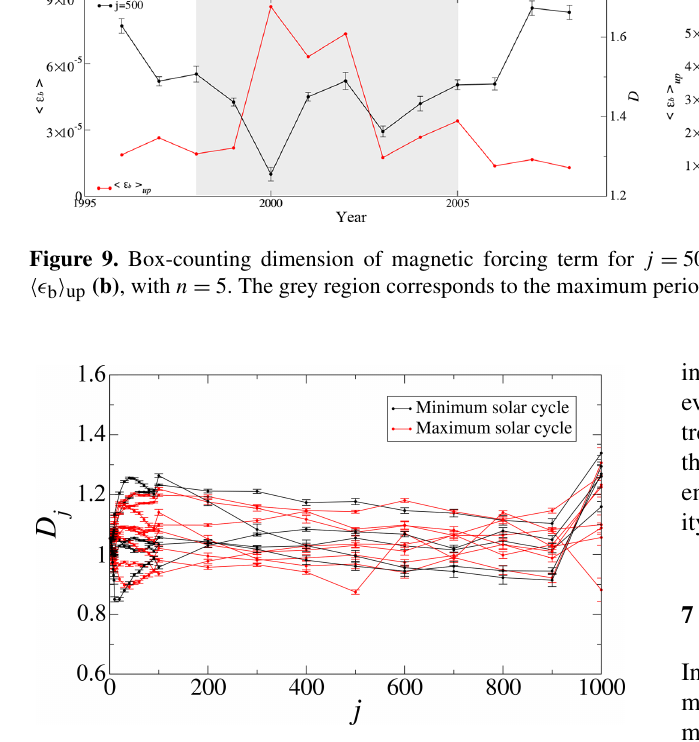
Figure 10. Box-counting dimension of energy dissipation rate for different values of j . Curves are distinguished for years correspond- ing to maximum (black lines: years 1998 to 2005) or minimum (red lines: years 1996, 1997, and 2006 to 2008) of the solar